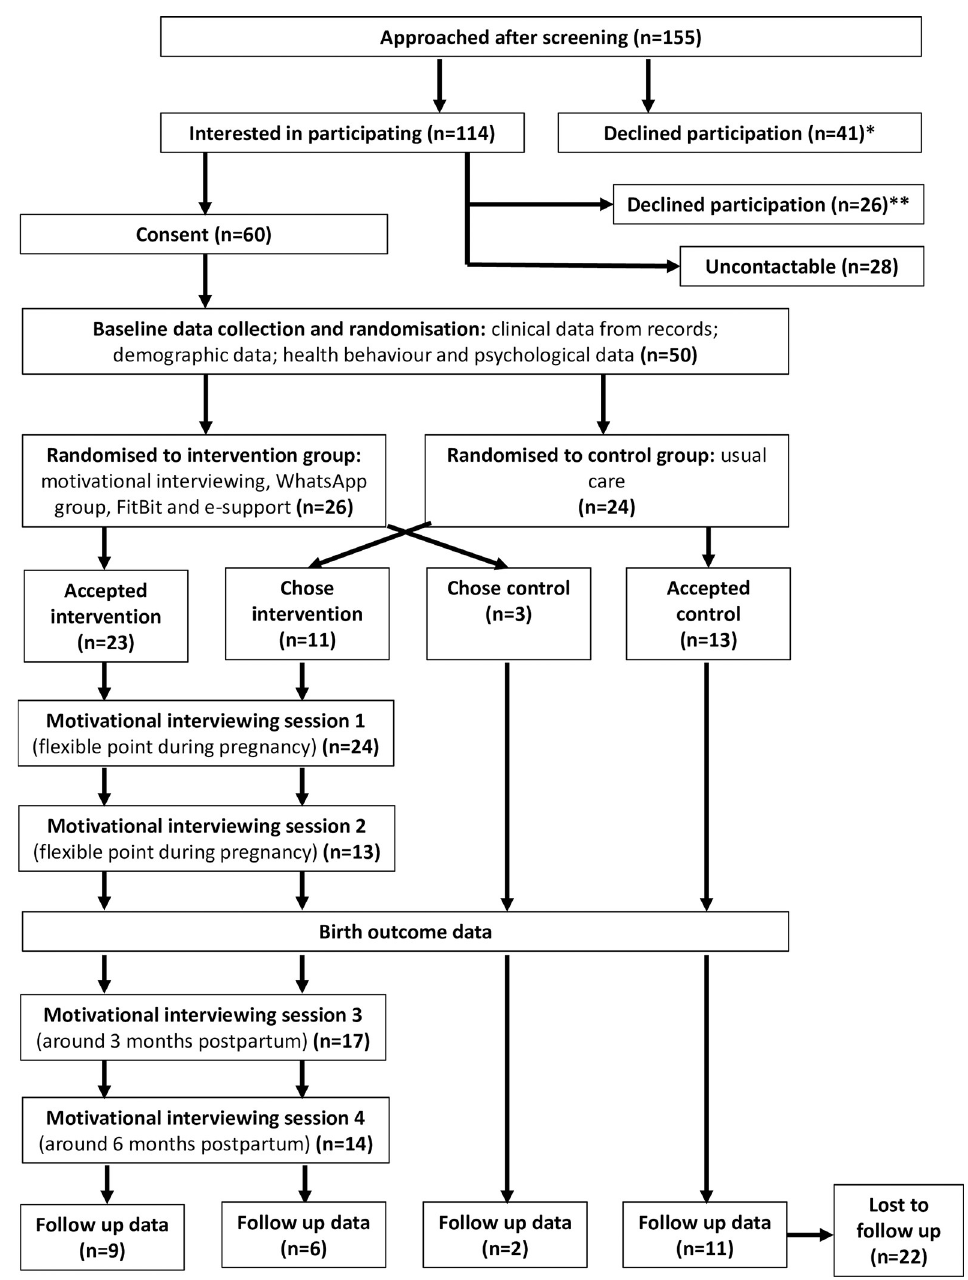
Fig 1. Overview of GODDESS model (underpinning techniques and behavioural mechanisms). EPE = ‘Elicit, Provide, Elicit’. OARS = ‘Open questions, Affirmations, Reflections, Summaries’. EE = ‘Express Empathy’. RR = ‘Roll Resistance’. DD = ‘Develop Discrepancy’. SS = ‘Support Self-efficacy’. SMART = Simple, Measurable, Achievable, Relevant, Time based. informed by the prior qualitative work and patient and public involvement (PPI) group, which indicated the need for emotional support within the behavioural intervention. PPI also sug- gested that an intervention initiated in pregnancy and continuing postpartum was optimal, and therefore we offered two antenatal (timing dependent on timing of diagnosis and